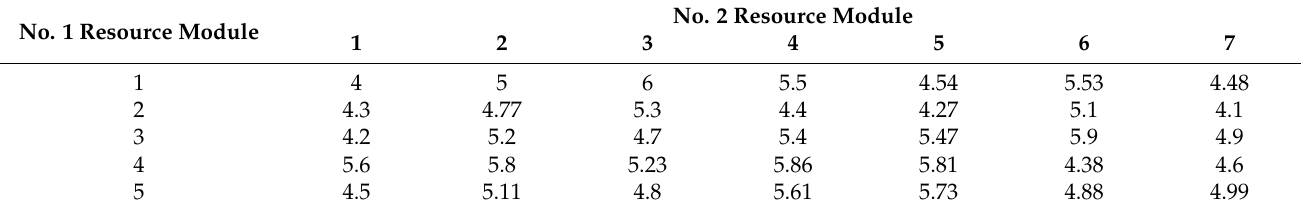
Table 2. The handover time consumption between No.1 and No.2 subtask module (H).